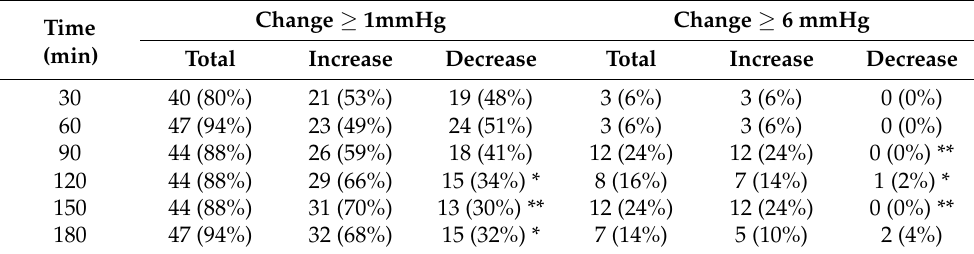
Table 2. Number of episodes with changes in IOP compared to pre-HDF.